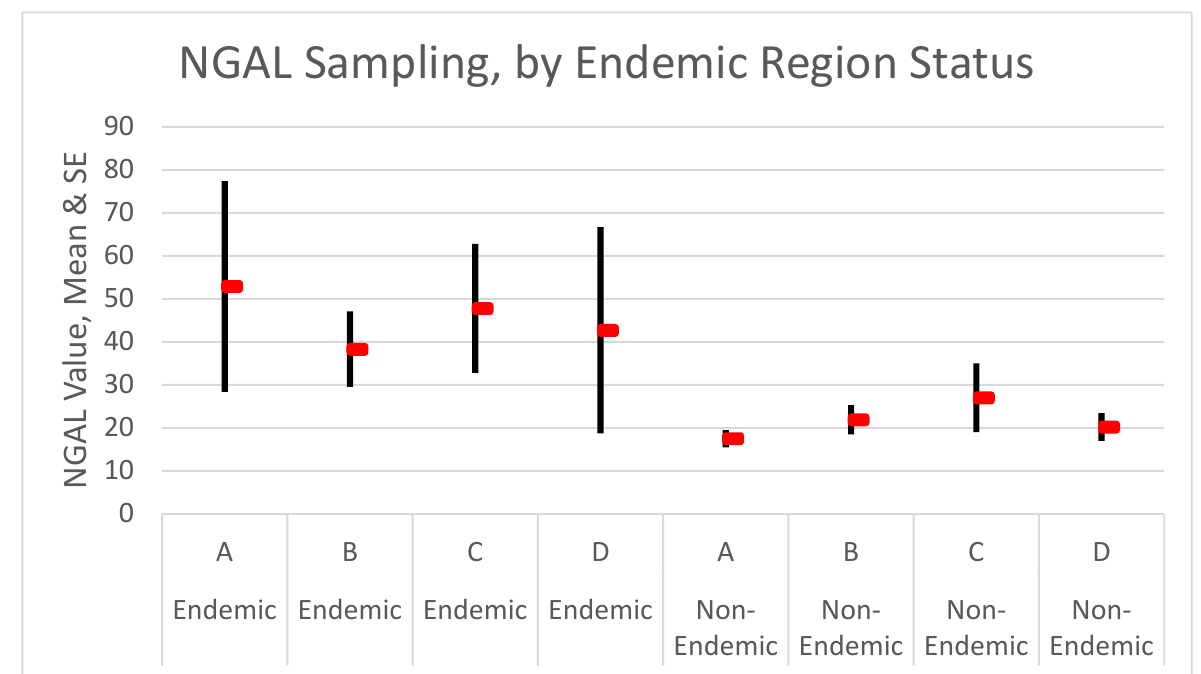
Figure 4. NGAL by endemic region. Values for the endemic region ( A – D ) were 72, 69, 65, and 68; and for the non-endemic region were 76, 74, 71, and 70. Red bars indicate mean values and the lines standard errors.